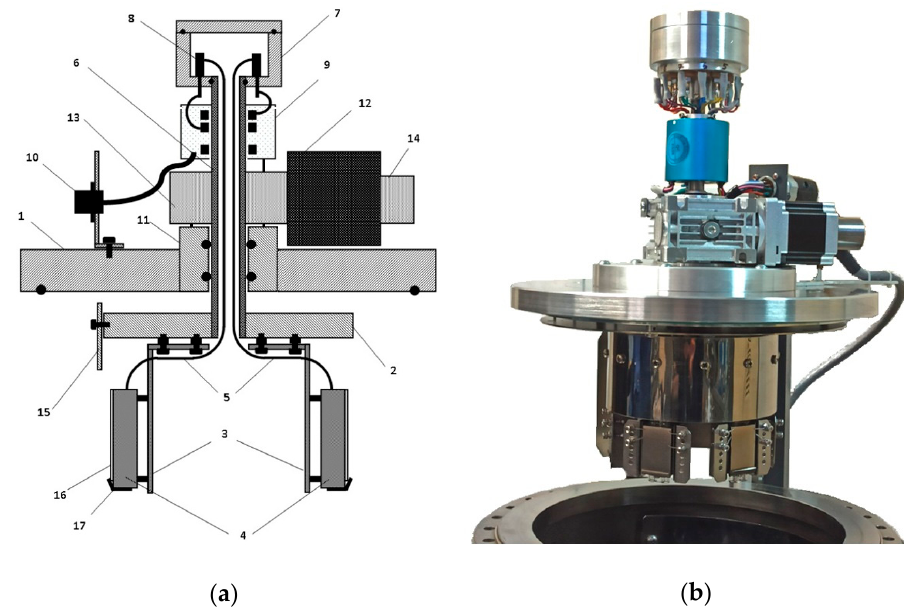
Figure 1. ( a ) Functional scheme of the multi-position drum-type assembly (MPDTA); ( b ) Appearance of the MPDTA mounted on the upper lifting flange of the sputtering